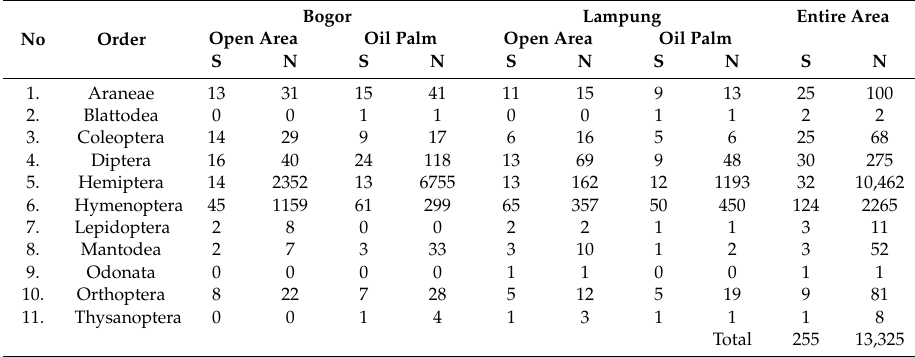
Table 1. Insects diversity associated with C. odorata collected by vacuum methods both in Bogor and Lampung. S: species richness, N: number of individuals.